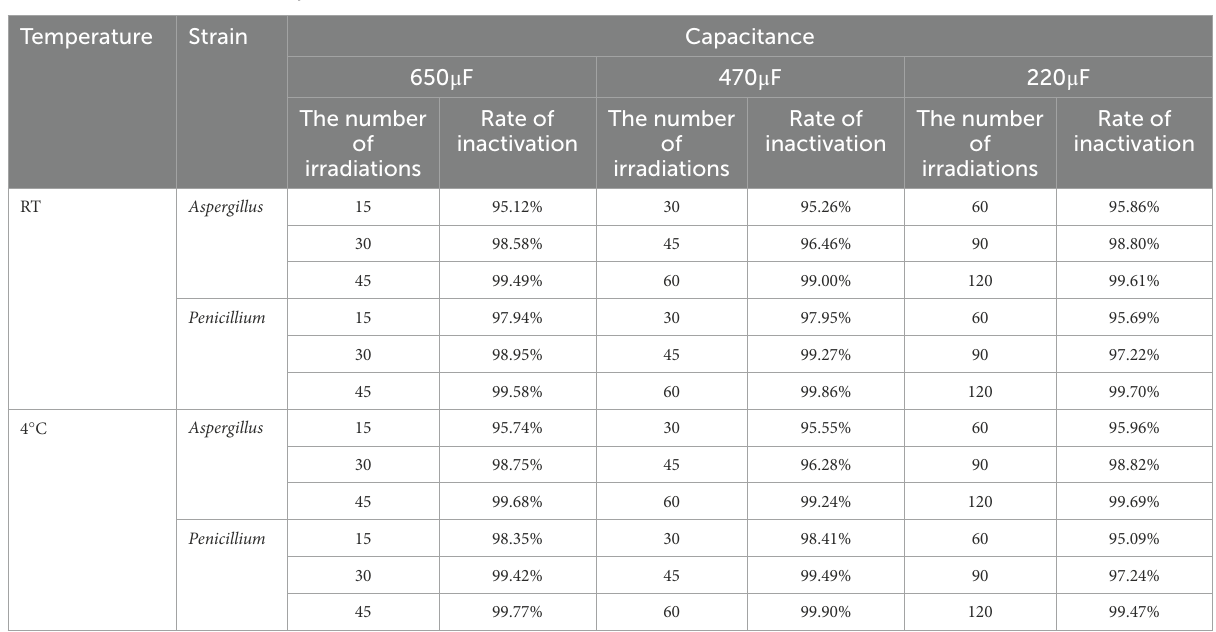
TABLE 1 Inactivation rate of IPL on planktonic cultures.